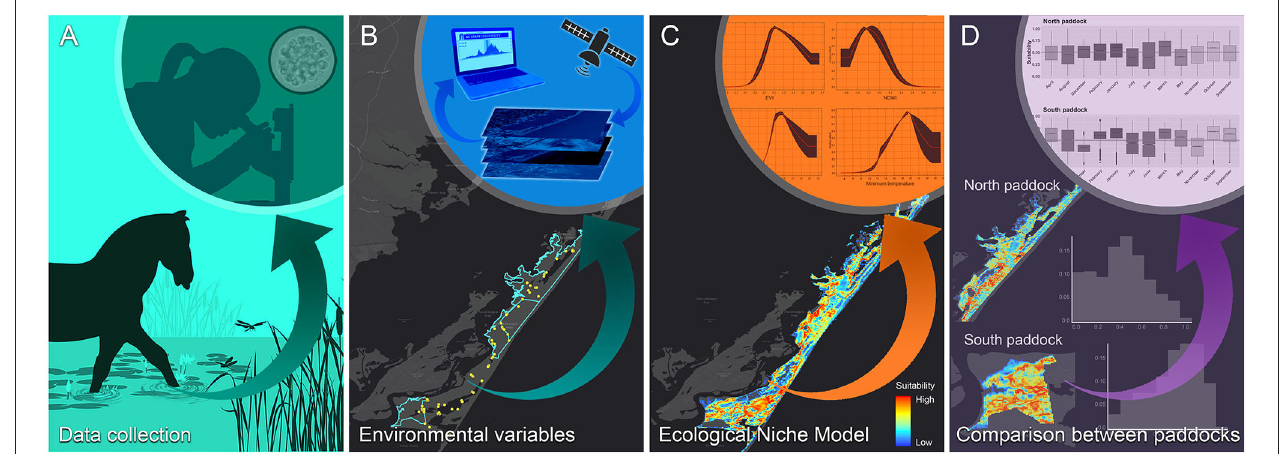
FIGURE 1 | The study workflow. (A) Fieldwork for water sample collection and Pythium insidiosum laboratory identification; (B) gathering of environmental and landscape variables relevant for the Chincoteague National Wildlife Refuge; (C) ecological niche model calibration, and (D) suitability of the northern and southern grazing areas “paddock”